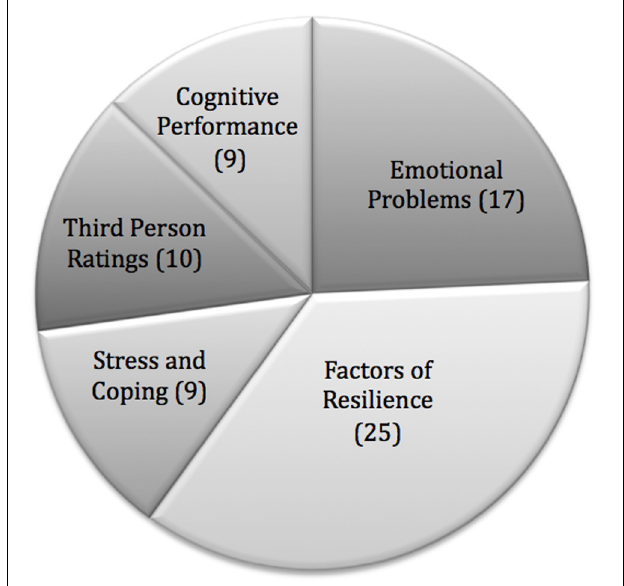
FIGURE 2 | Numerical proportions of measures applied in